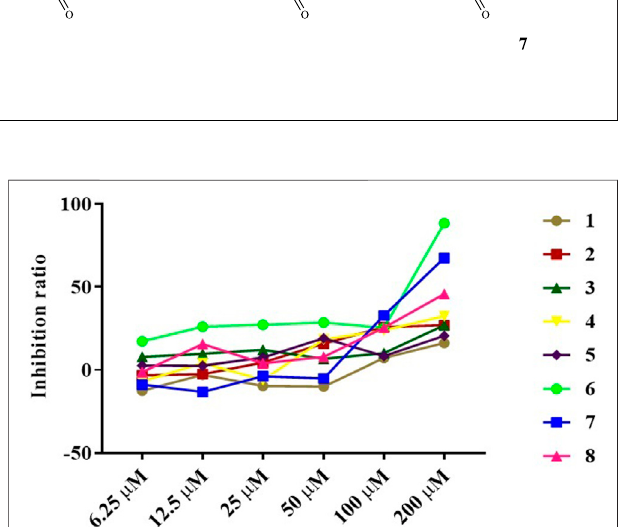
FIGURE 5 | RAW 264.7 macrophage viability test of the isolated